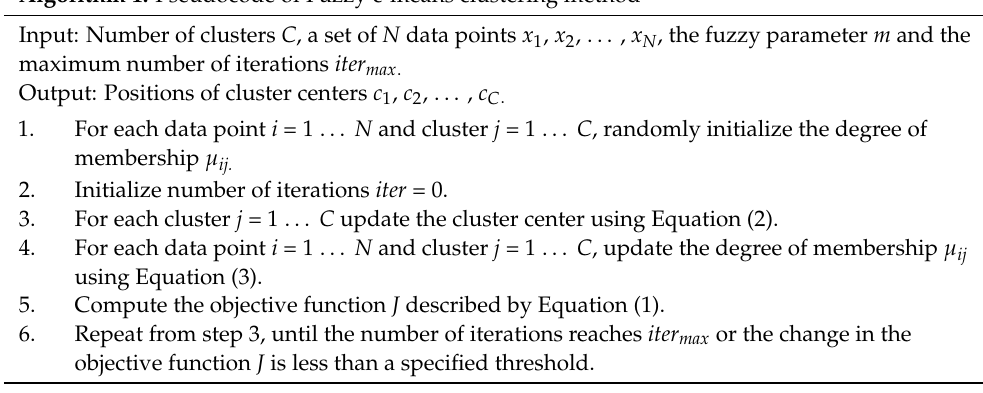
Algorithm 1. Pseudocode of Fuzzy c-means clustering